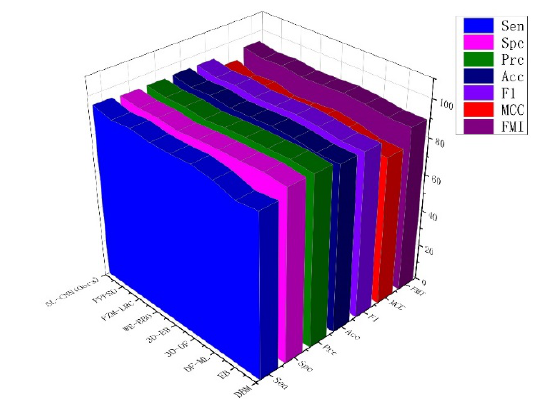
Fig. 13 Performance